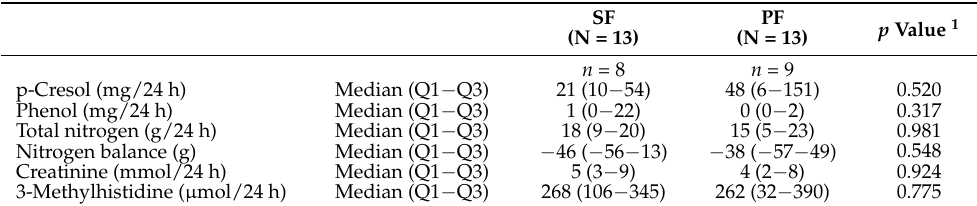
Table 4. Urinary parameters.